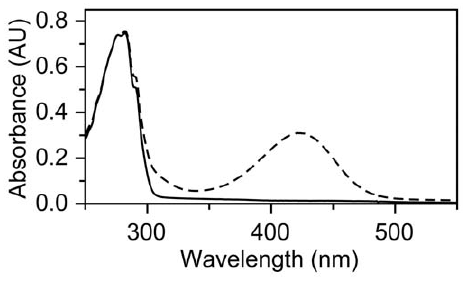
Figure 4. Spectroscopic characteristics of apoflavodoxin mod- ified with NBD. Apoprotein (20 m M) before (solid line) and after (dashed line) incubation with 200 m M NBD-Cl for 1 hour. Modified protein absorbs maximally at 420 nm, which is characteristic for the presence of a thiol-NBD conjugate [47].